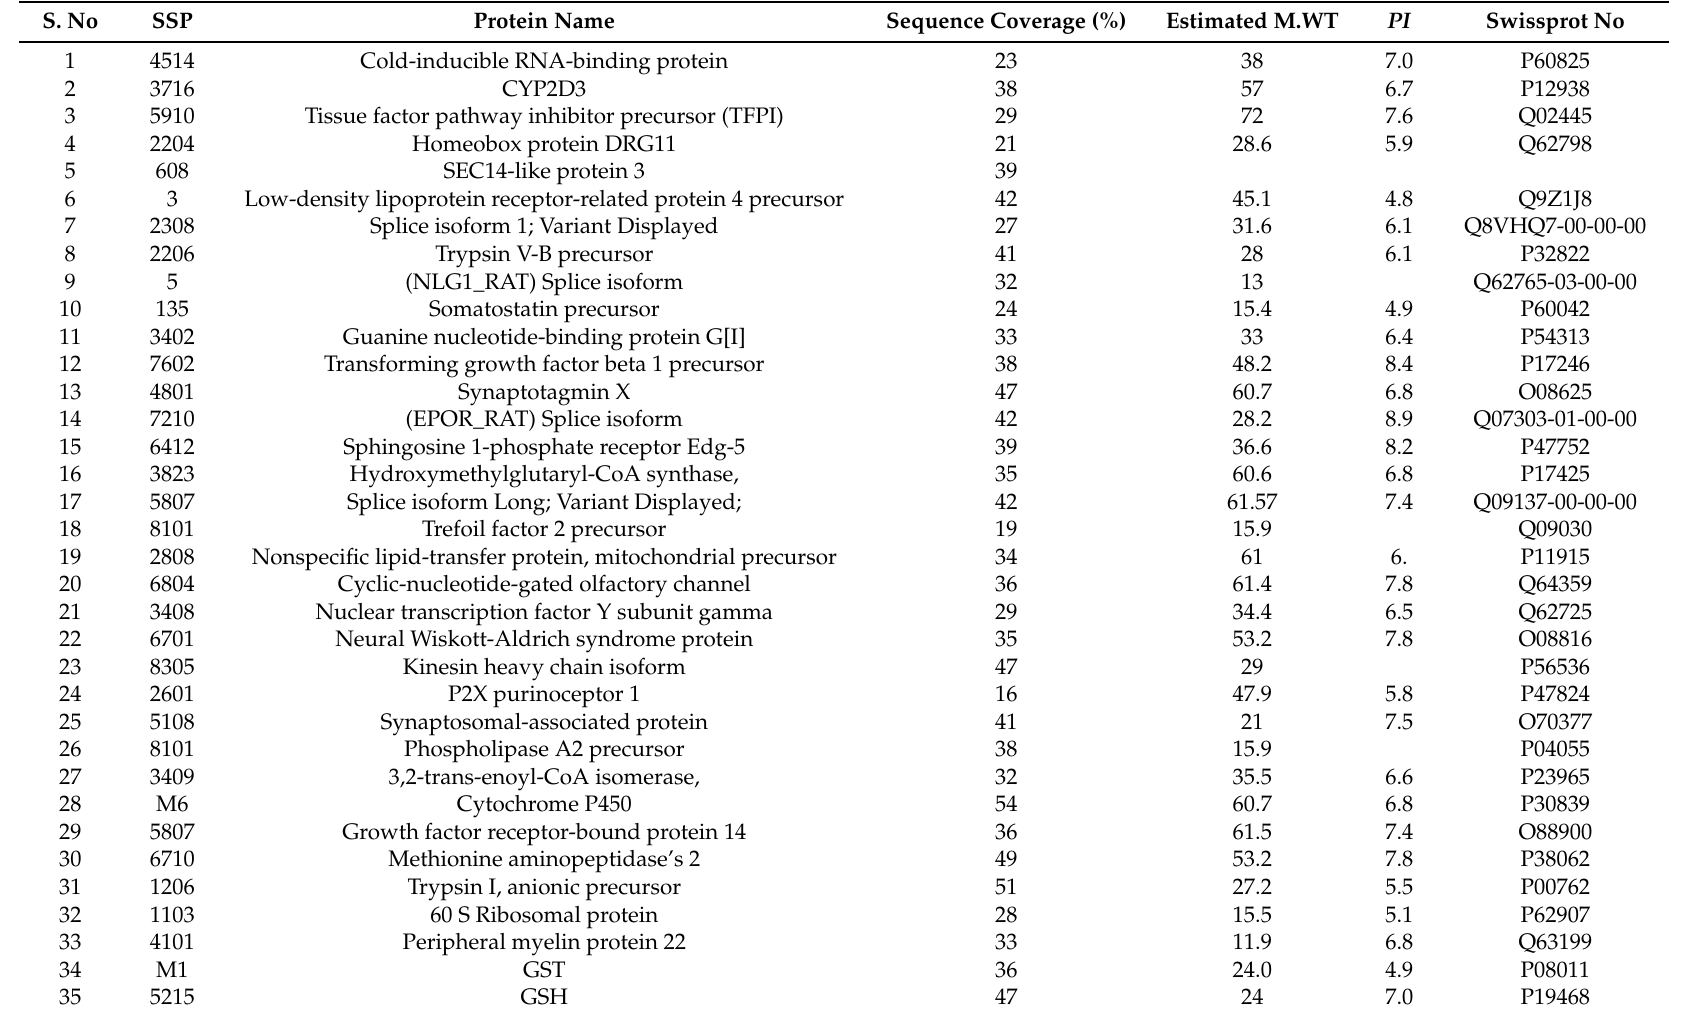
Table 2. Differentially expressed proteins in rats received 150 mg/kg of